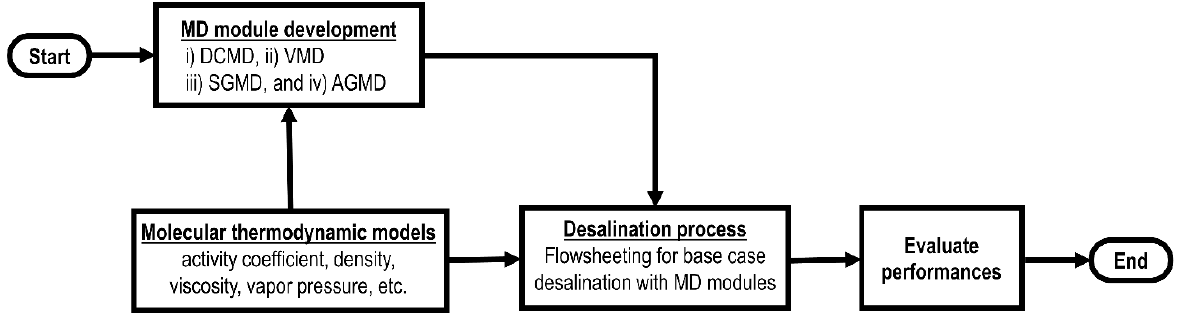
Figure 3. Flowchart for performance calculation of MD-based desalination.